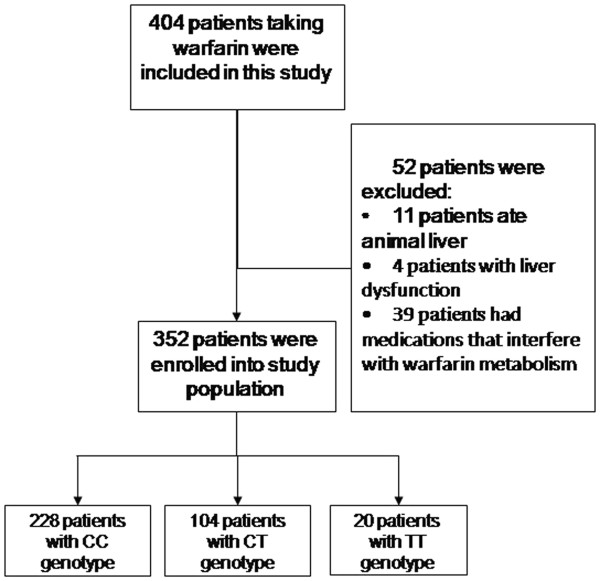
Flow chart of study enrollment and patient exclusion.